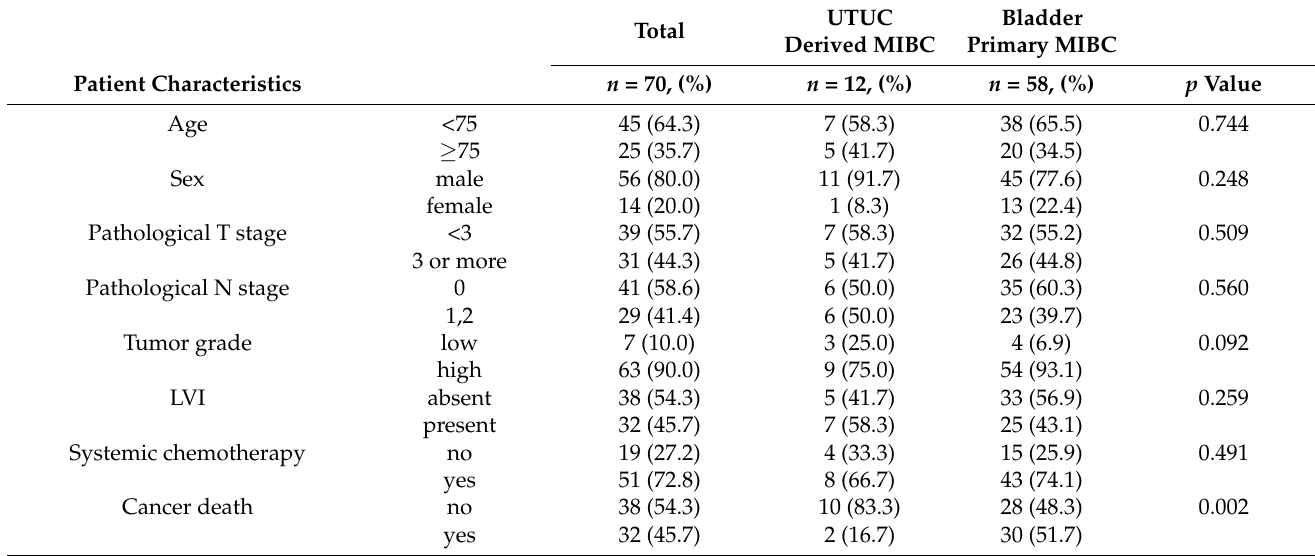
Table 5. Patient and tumor characteristics of MIBC patients who underwent radical cystectomy. Abbreviations: MIBC; muscle invasive bladder cancer, UTUC; upper tract urothelial carcinoma, LVI; lymphovascular invasion.